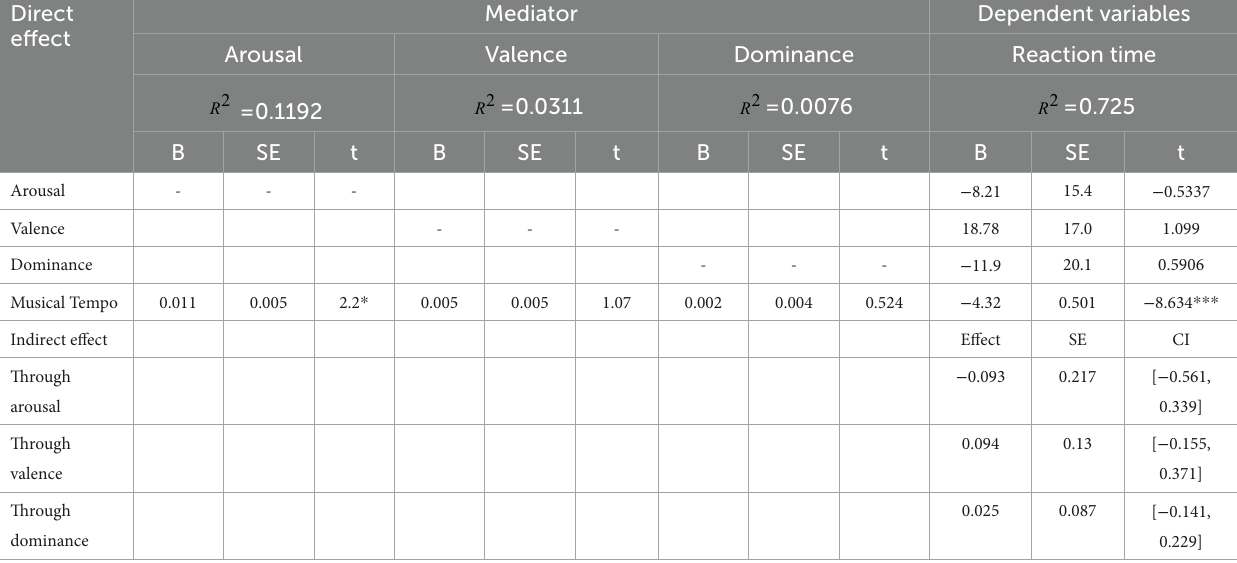
TABLE 4 Results of mediation analysis. Direct